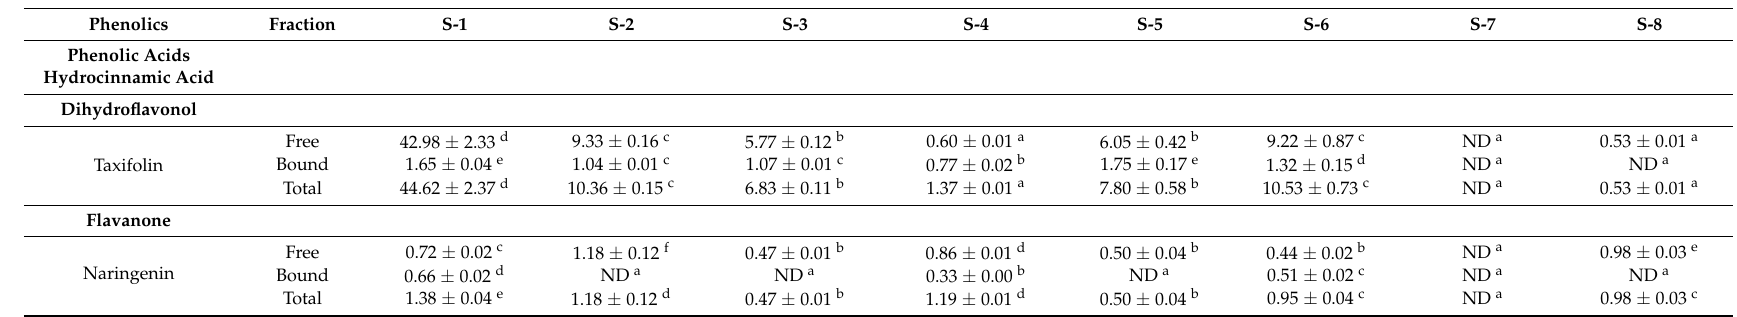
Table 5. Antioxidant capacity (mg VcE 1 /g grain, DW 2 ) 3 of free and bound phenolic extract measured by 2,2-diphenyl-1-picrylhydrazyl radicals (DPPH) and ferric reducing ability of plasma (FRAP) assays.